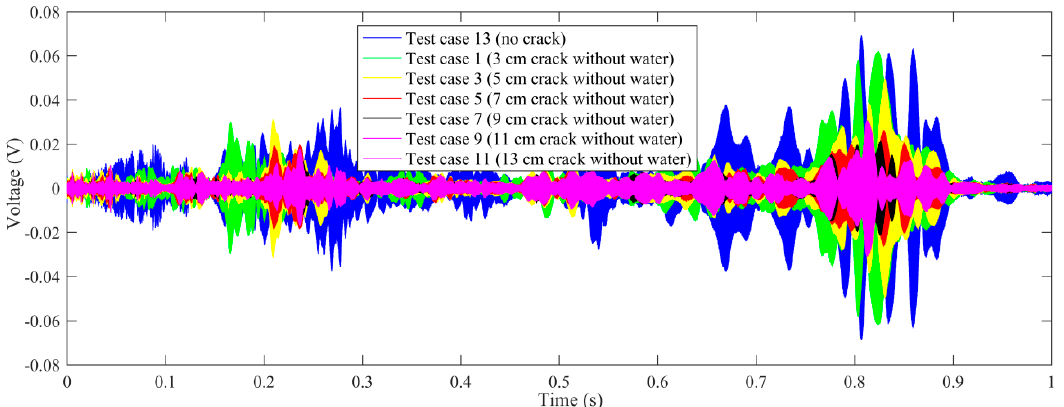
Figure 9. The comparison of voltage signals (test case: no crack and all cracks without water).